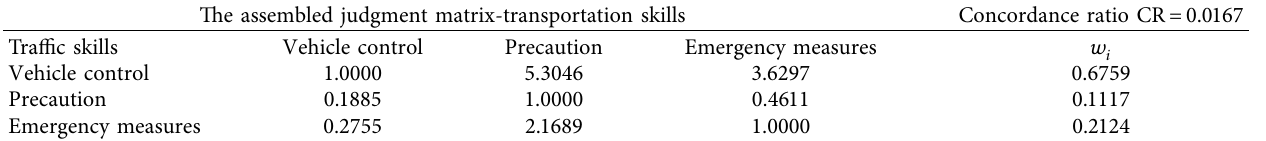
Table 5: Discrimination matrix of traffic skill secondary indicators and weight.